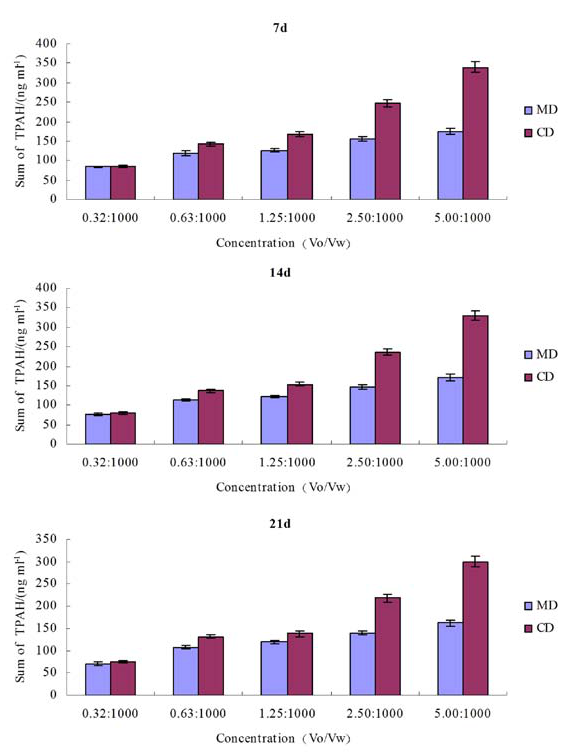
Fig. 3. – Concentration of total PAHs in the intestine of sea urchins exposed to CDWAF and MDWAF within different exposure times (7d, 14 d and 21 d).